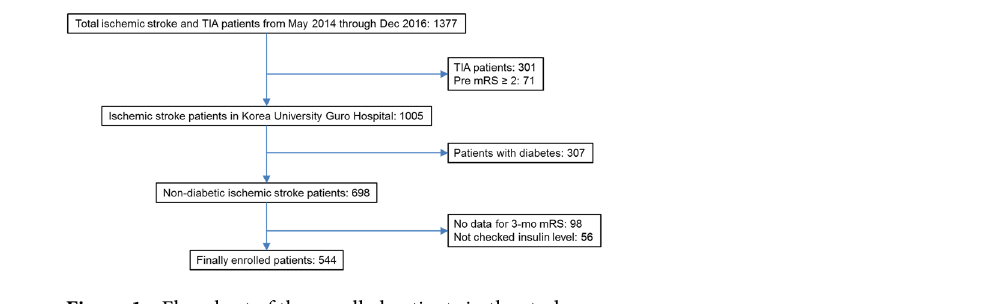
Figure 1. Flowchart of the enrolled patients in the